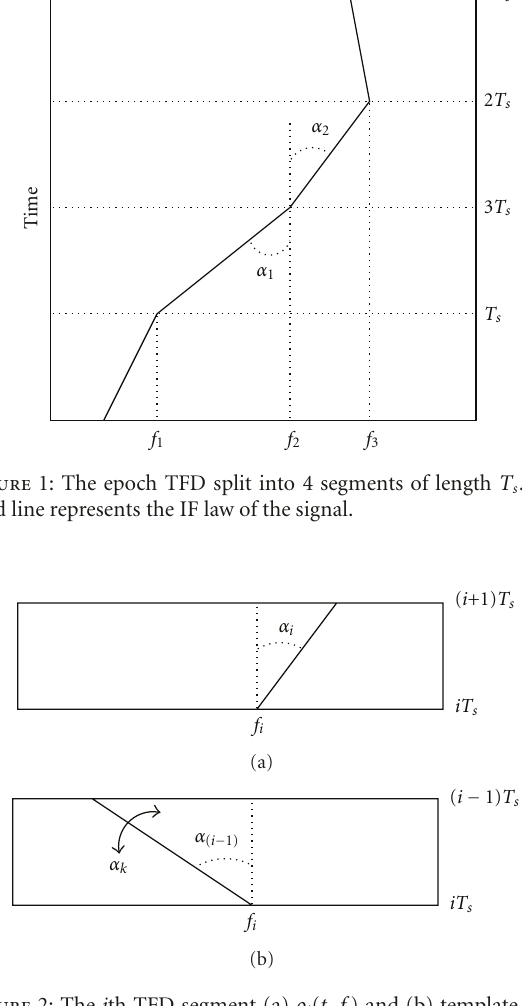
Figure 2: The i th TFD segment (a) ρ i ( t , f ) and (b) template TFD ( t , f ; θ k ). Note that the template TFD is a time-reversed version ρ T i of the ( i − 1) TFD segment. The template TFD is rotated about a set of slope values to attempt a match with the i th TFD segment. This example is taken from Figure 1 for i =